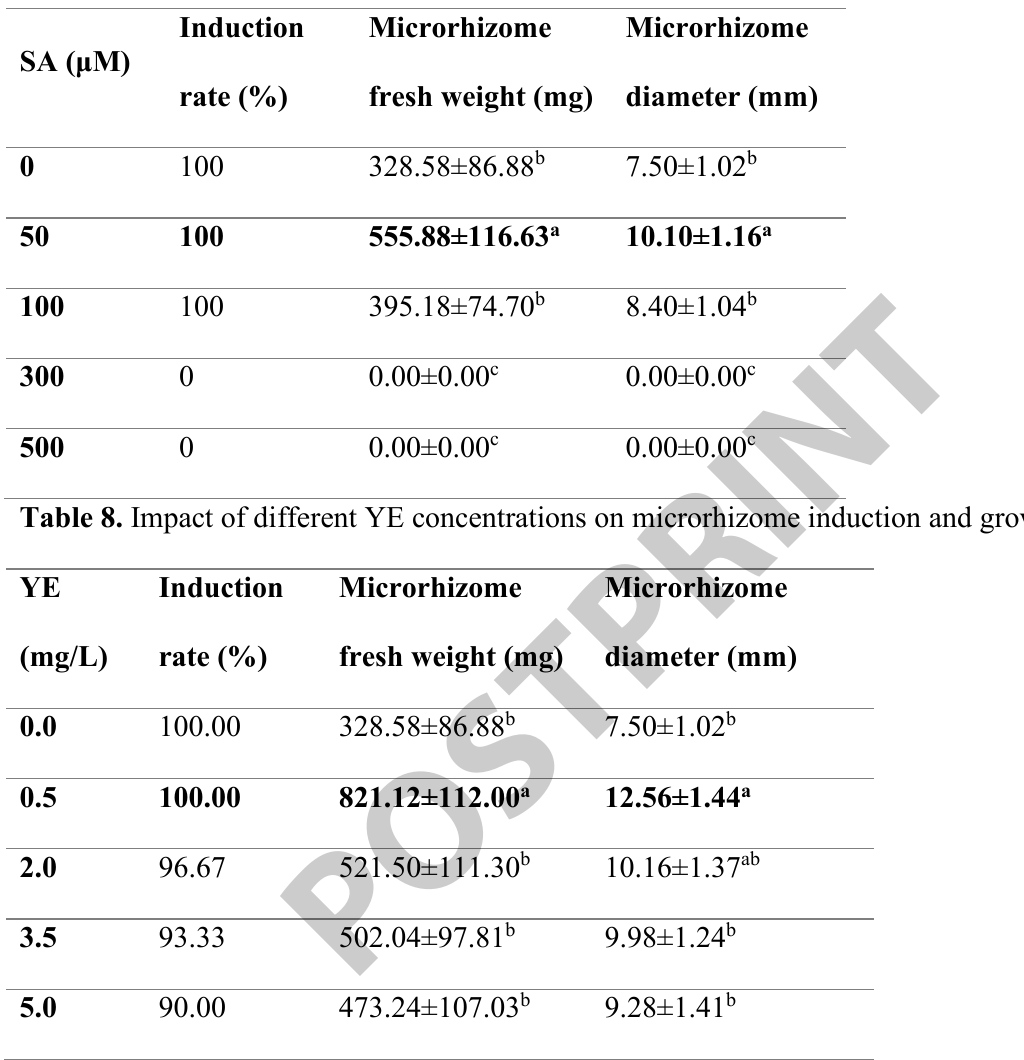
Table 7. Impact of different salicylic acid (SA) concentrations on microrhizome induction and growth